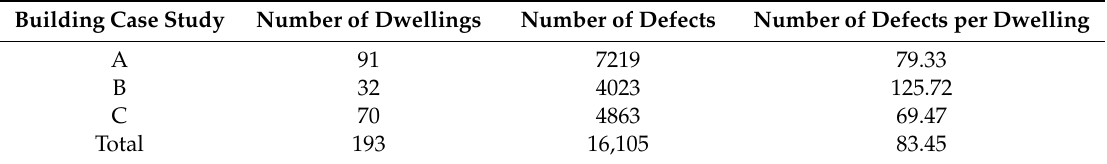
Table 7. Number of defects detected when the inspections were conducted in the three building case studies where the Procedure was implemented (Do